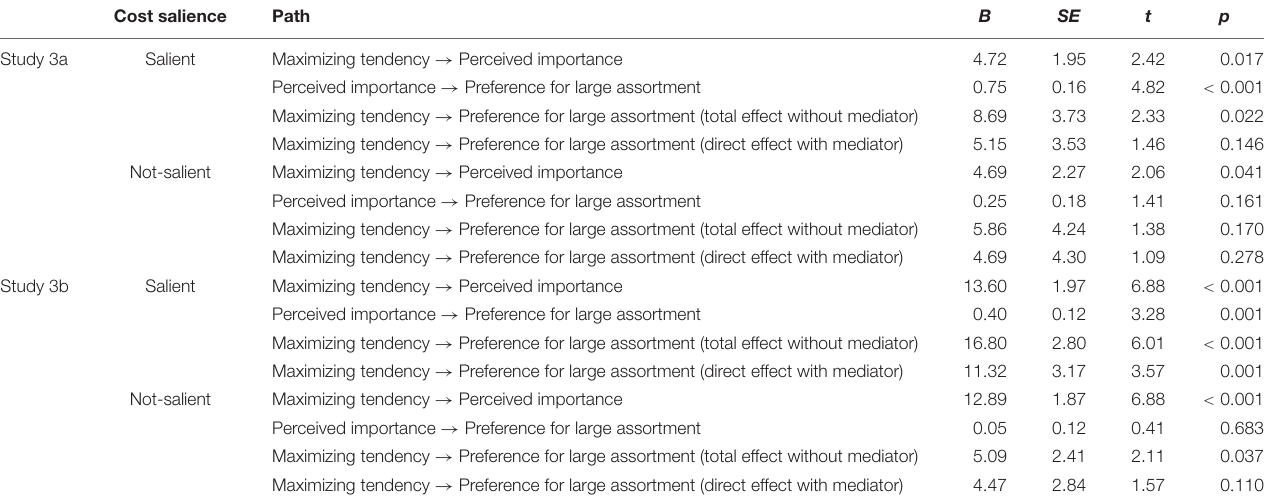
TABLE 2 | Moderated mediating analysis from Studies 3a and